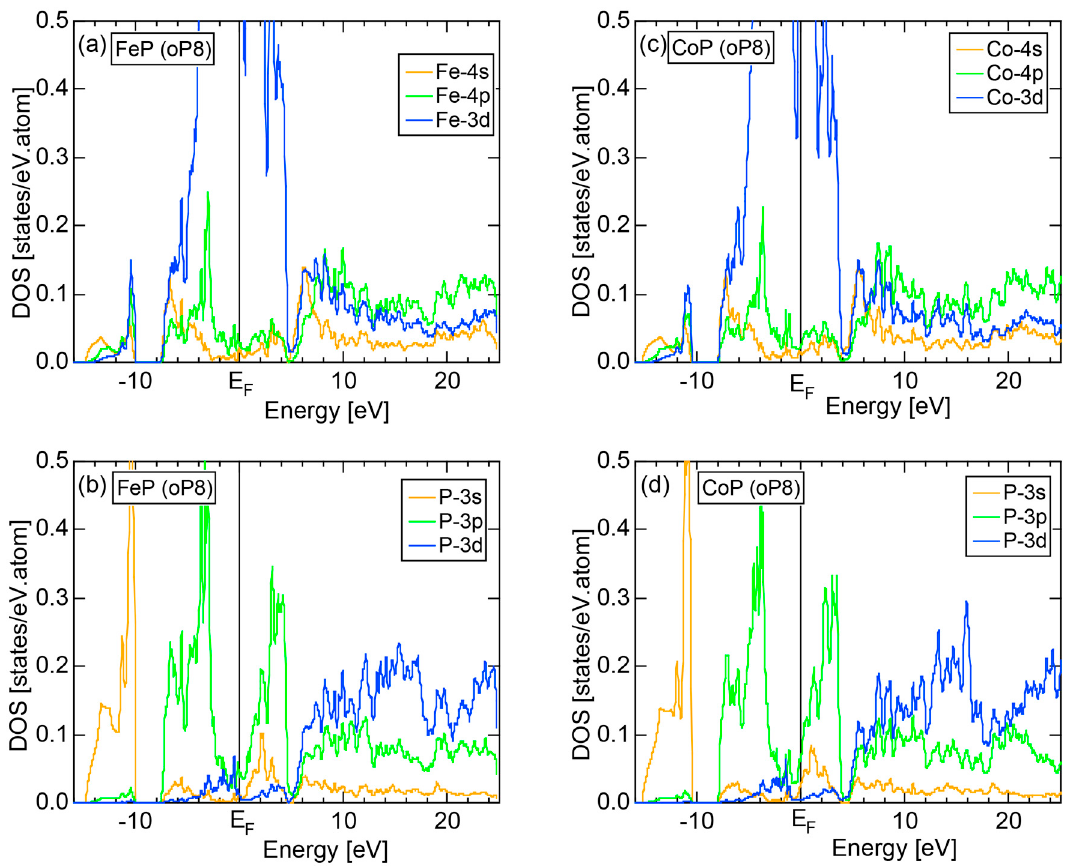
Figure 82. ( a ) Fe- and ( b ) P-pDOSs for FeP (oP8) and ( c ) Co- and ( d ) P-pDOSs for CoP (tI32) [11].